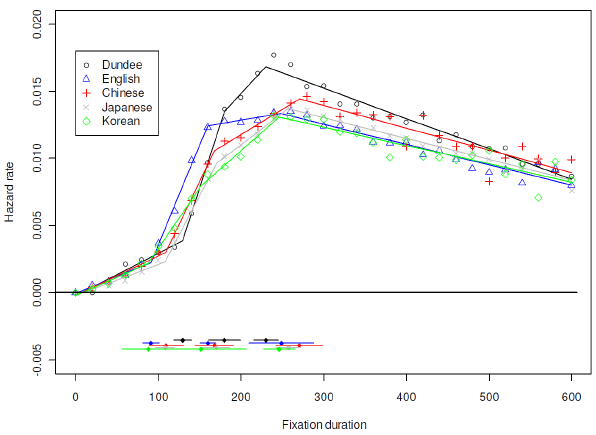
Figure 3. Hazard Functions by